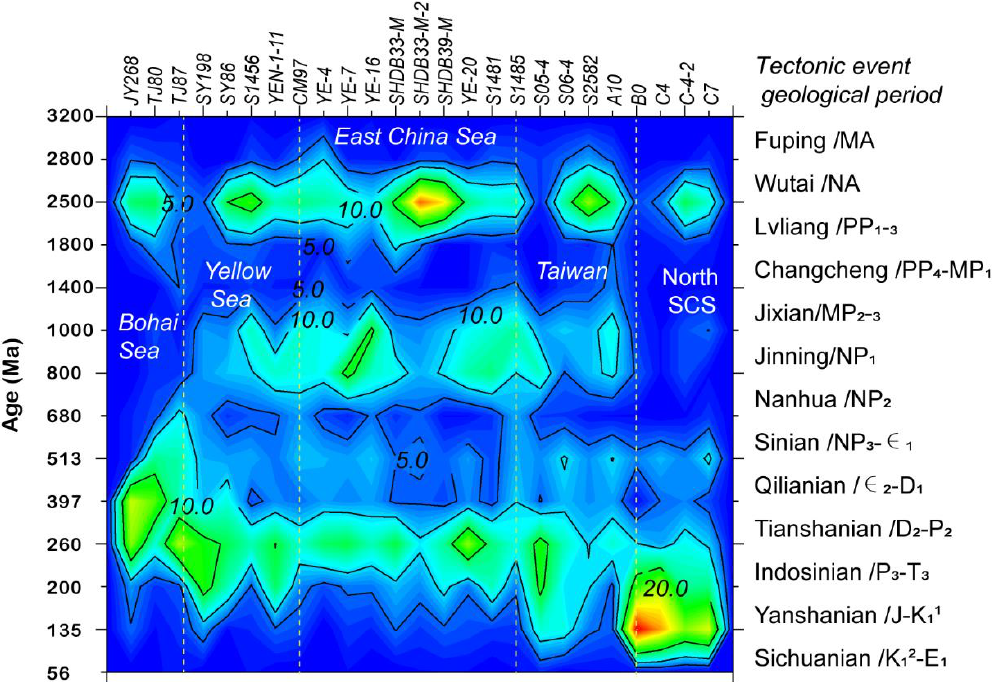
Figure 7. Spatial variation in the relative abundances of different zircon age populations in the east China seas. Zircon age populations are classified according to tectonic events that happened in the geological history of East Asia [70]. The yellow dashed lines are used to mark samples taken from different seas.